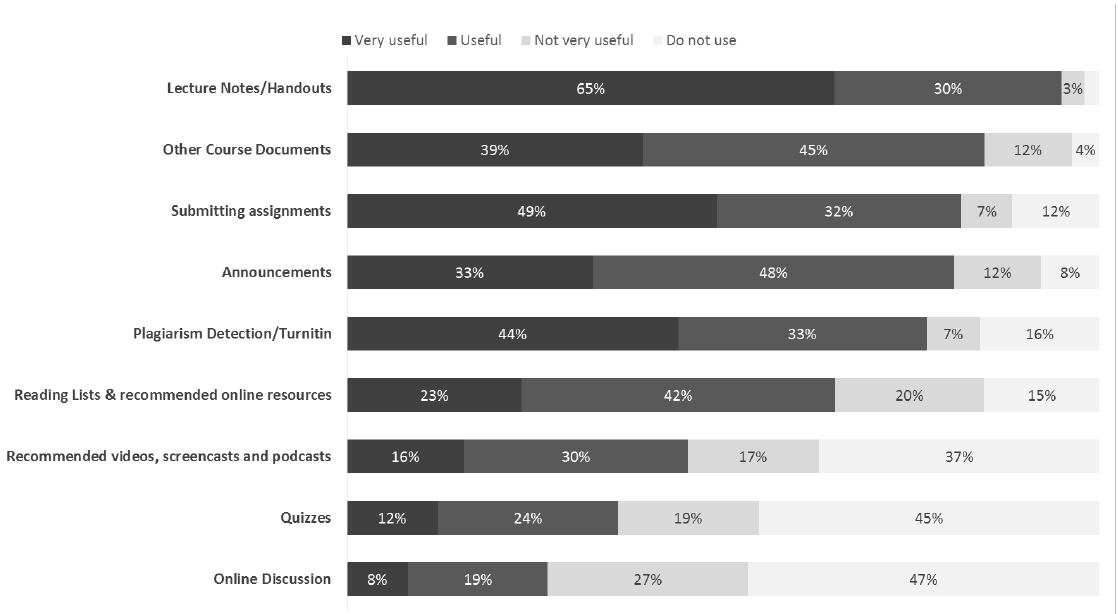
Figure 1: Student ratings of VLE features in